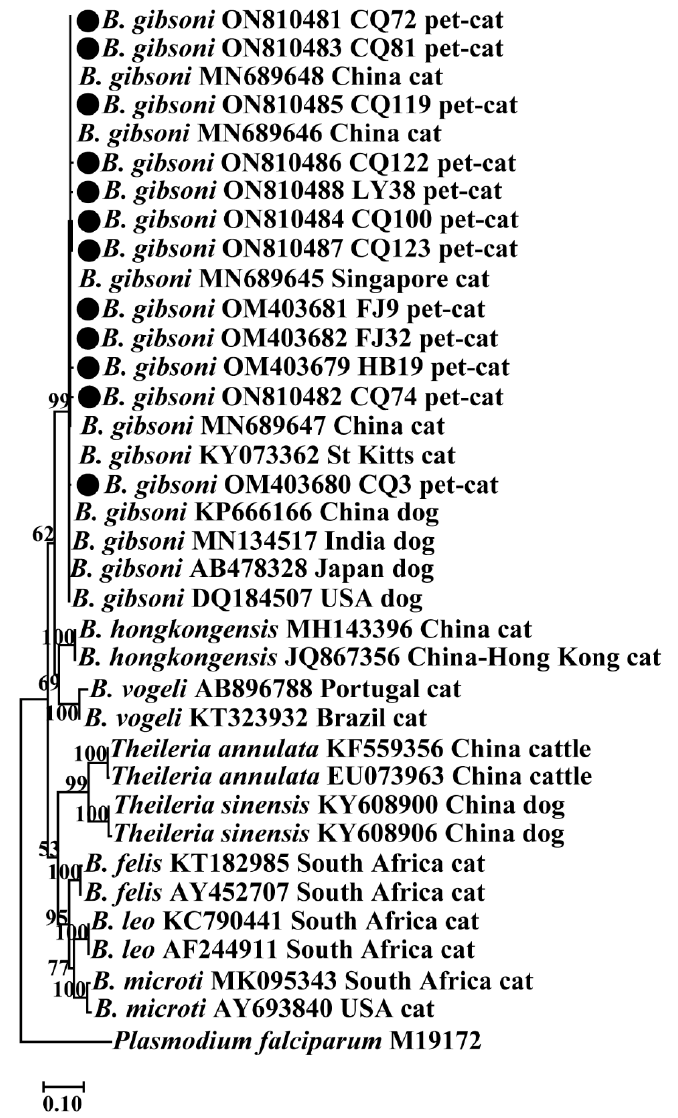
Figure 4. Phylogenetic tree constructed using 18S rRNA sequences from Babesia spp. by neighbor- joining. The sequences obtained from this study were compared with the related sequences deposited in GenBank. The bootstrap values of >50% were displayed at each branch point. GenBank accession numbers, the isolate, countries and host were shown alongside species names. The sequence of Plasmodium falciparum (M19172) was used as outgroup. Representative isolates in this study were indicated by bold circles. Abbreviations: CQ (Chongqing), FJ (Fujian), HB (Hubei), LY